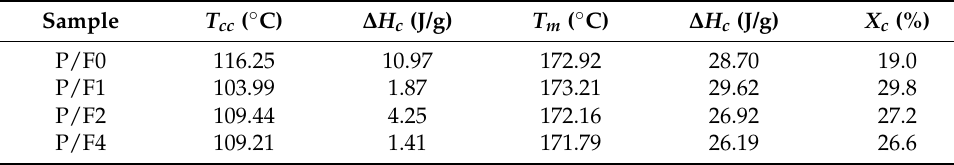
Table 3. The phase transition parameters of P/F films.